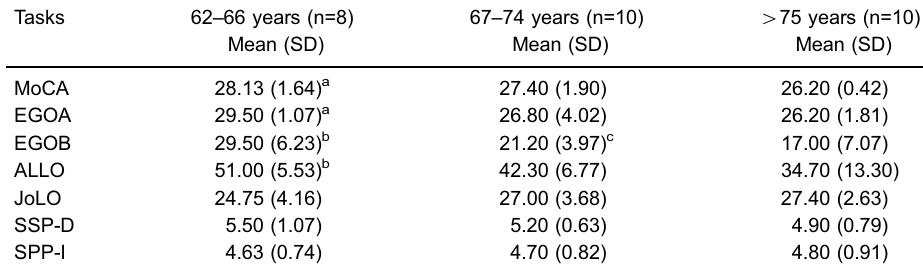
Table 2 . Mean and standard deviation for test scores across age groups. Tasks